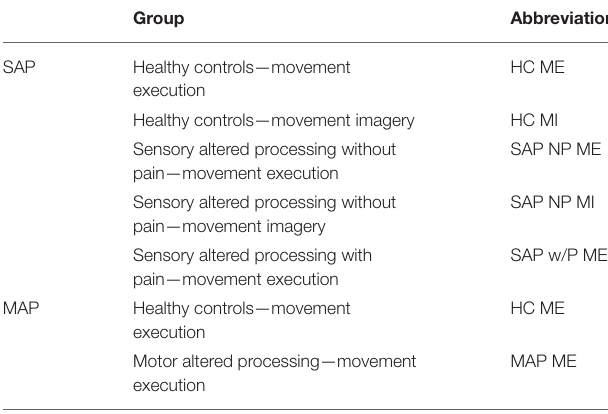
TABLE 2 | List of groups and abbreviations for single dataset analysis.